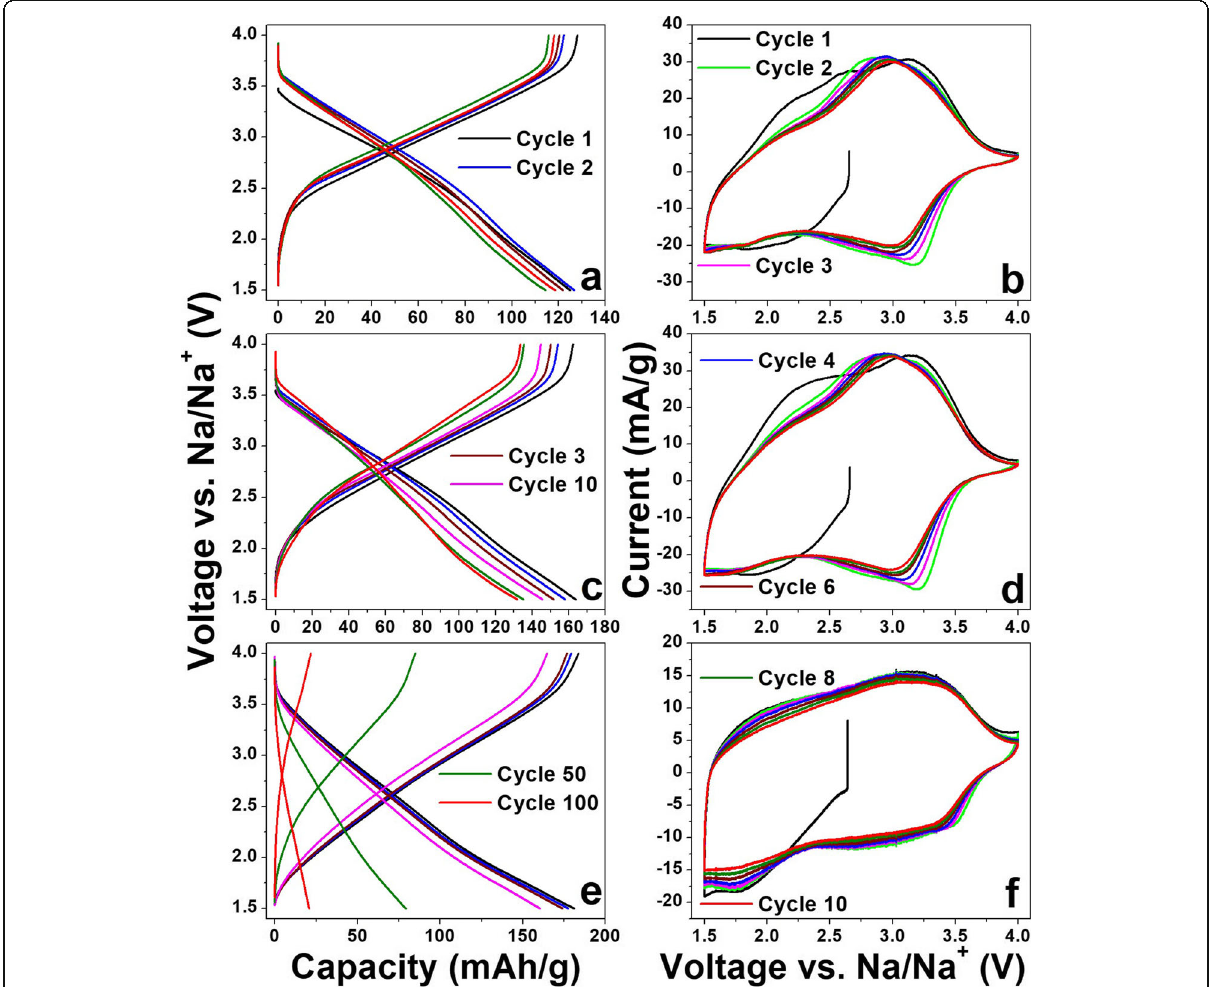
Fig. 7 Na-ion battery GC profiles of ( a ) a-VOx-6 Pa, ( c ) a-VOx-13 Pa and ( e ) a-VOx-30 Pa at 0.1 C and respective CV curves shown in ( b ), ( d ) and ( f